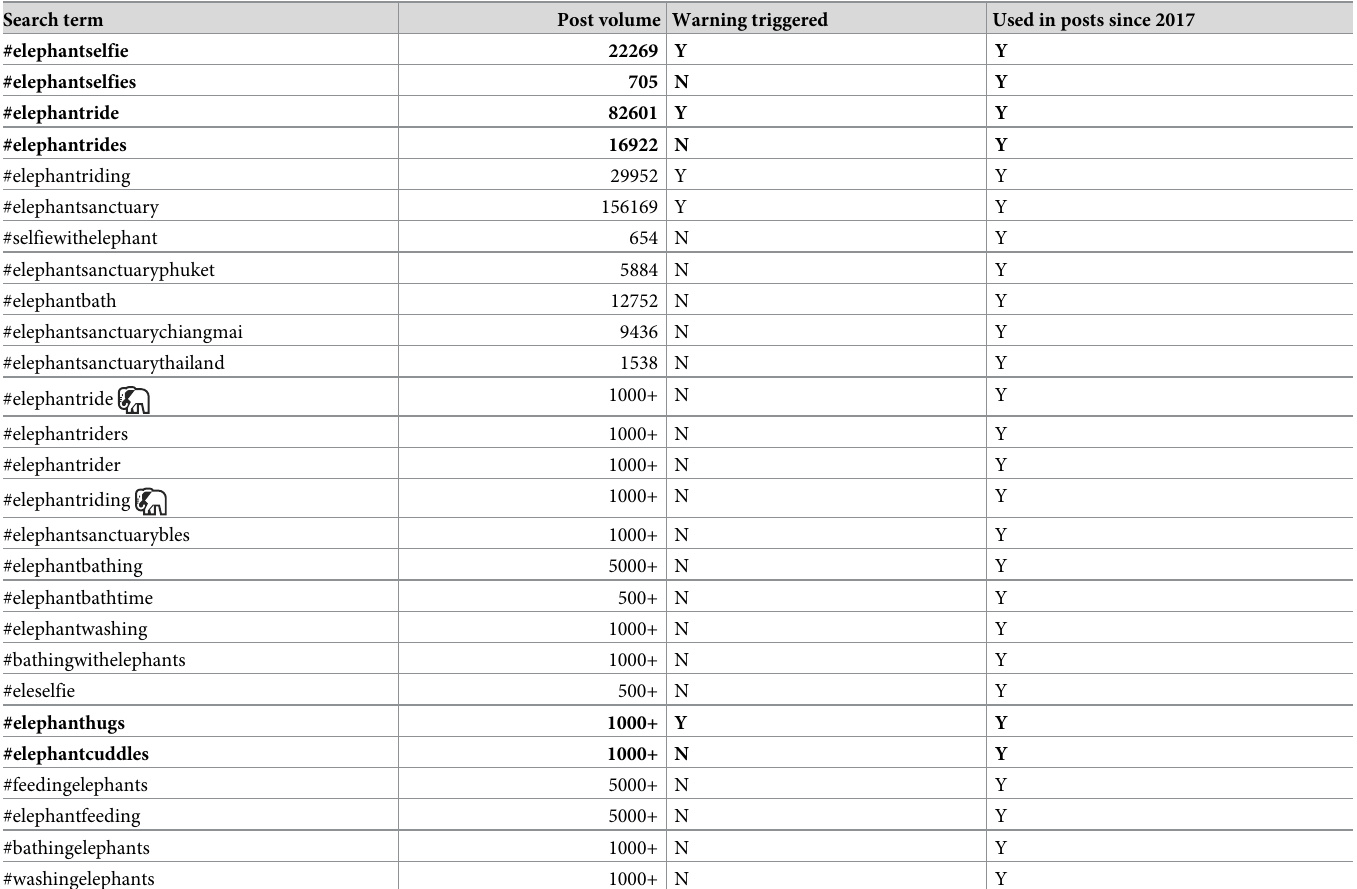
Table 2. Hashtags associated with elephant selfie posts on Instagram. Data shown are the post volume (the number of posts in which the hashtag was used), whether Instagram’s pop-up alert was triggered (Y = yes, N = no), and whether any of the posts had been posted (i.e. the hashtag had been used) since the warning was introduced in 2017. Not all posts conformed to our definition of an elephant selfie; hashtags were included if at least one post using it was relevant (see footnote). Only hashtags with a post volume > 500 are shown here, the full set of identified relevant hashtags is provided in S1 Appendix. Neither the list of hashtags here, or the full list of hashtags given in S1 Appendix, is intended to be exhaustive. Bold text indicates hashtags used for further